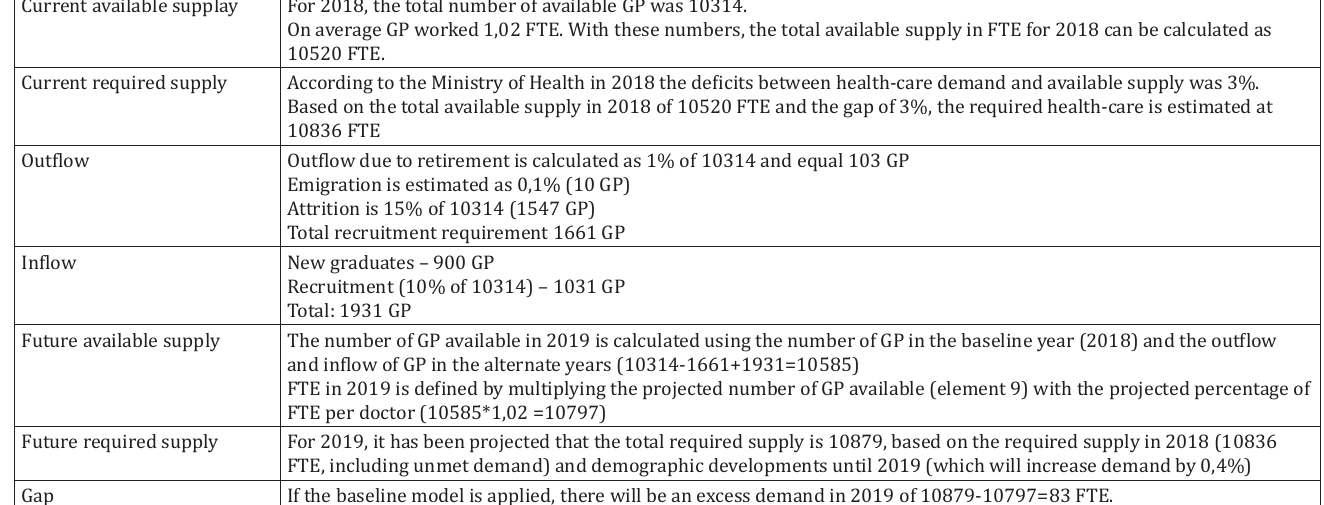
Model elements calculation